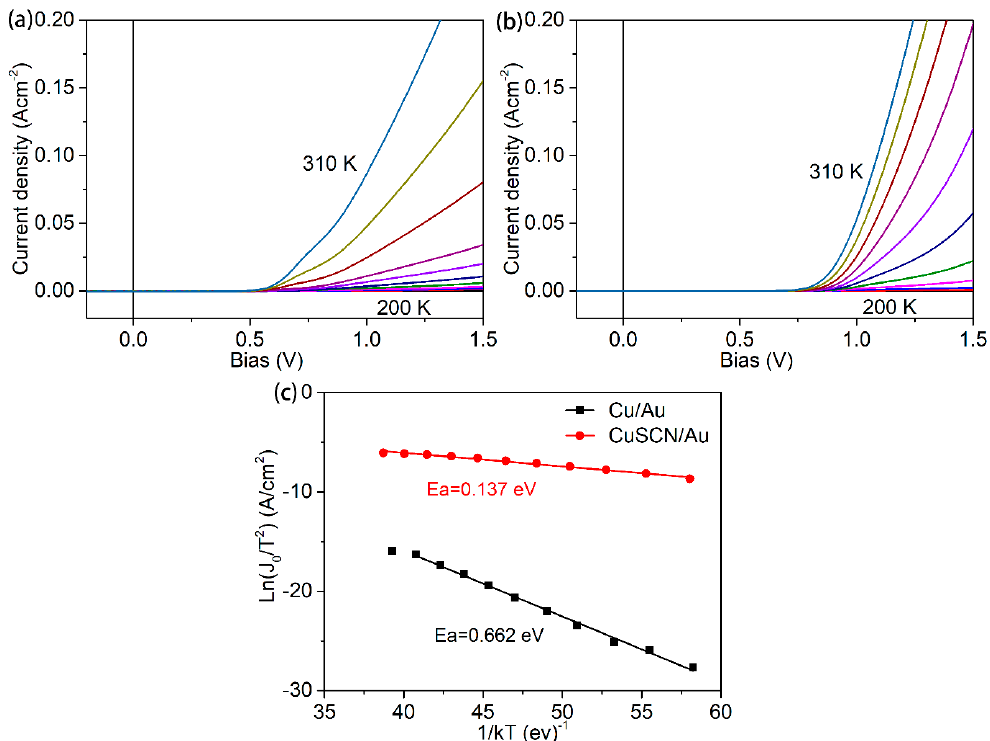
Figure 5. Temperature dependent dark J-V curves for devices with ( a ) Cu metal and ( b ) CuSCN as the back contact. ( c ) Arrhennius plots for the calculation of the back-barrier height for the devices with Cu metal and CuSCN as the back contact.